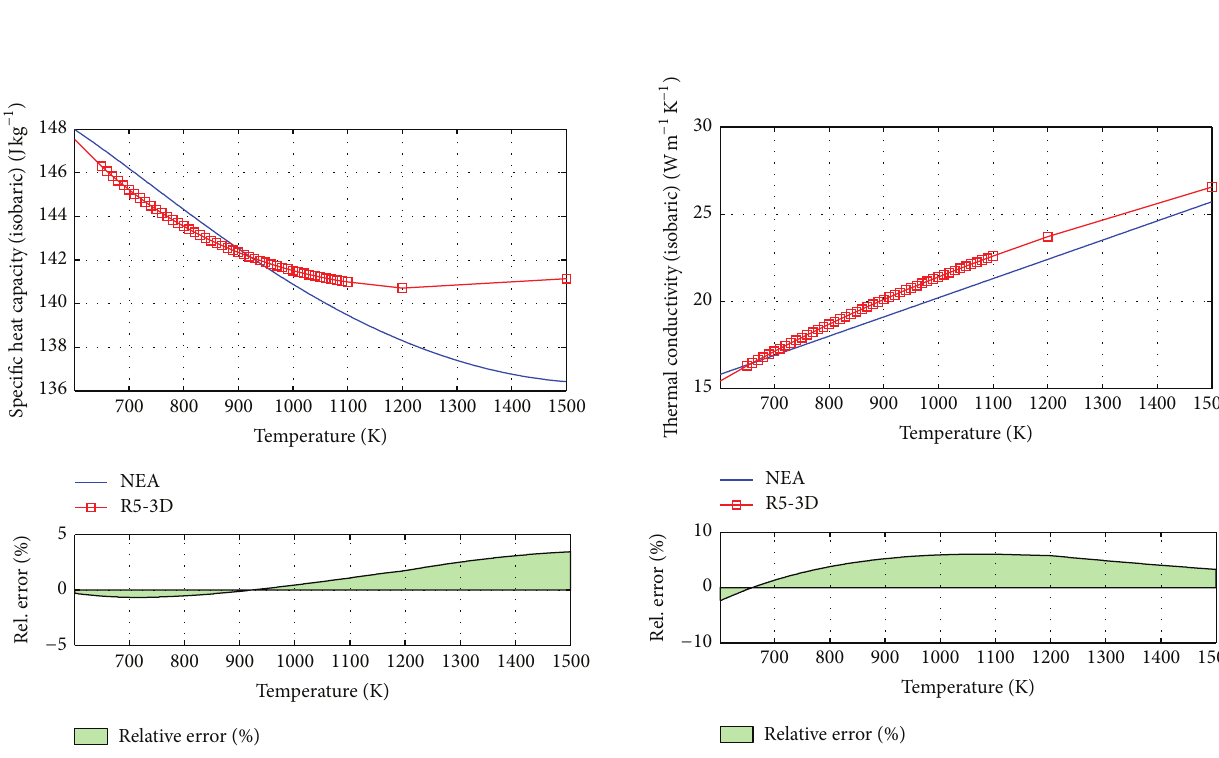
Figure 9: Lead liquid specific heat at constant pressure, original R5- 3D “tpf” file versus NEA report.